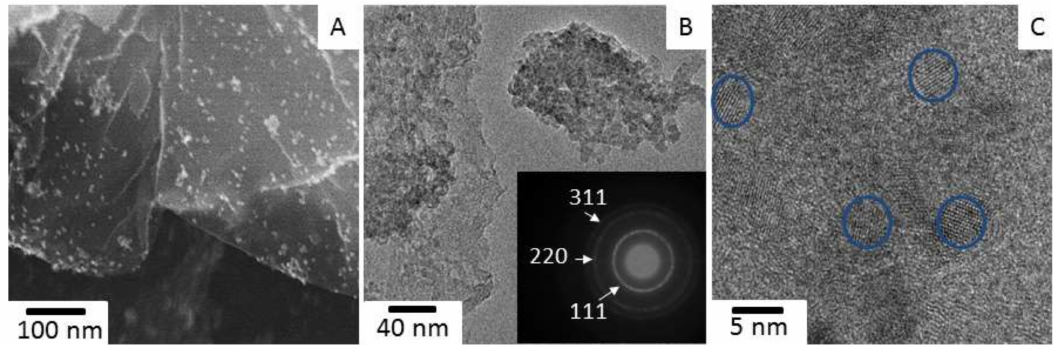
Figure 1. ( A ) SEM image; and ( B , C ) HRTEM of rGO/ZnS:Mn nanocomposite. Inset in ( B ) shows the SAED rings taken on the area of Figure 1B.